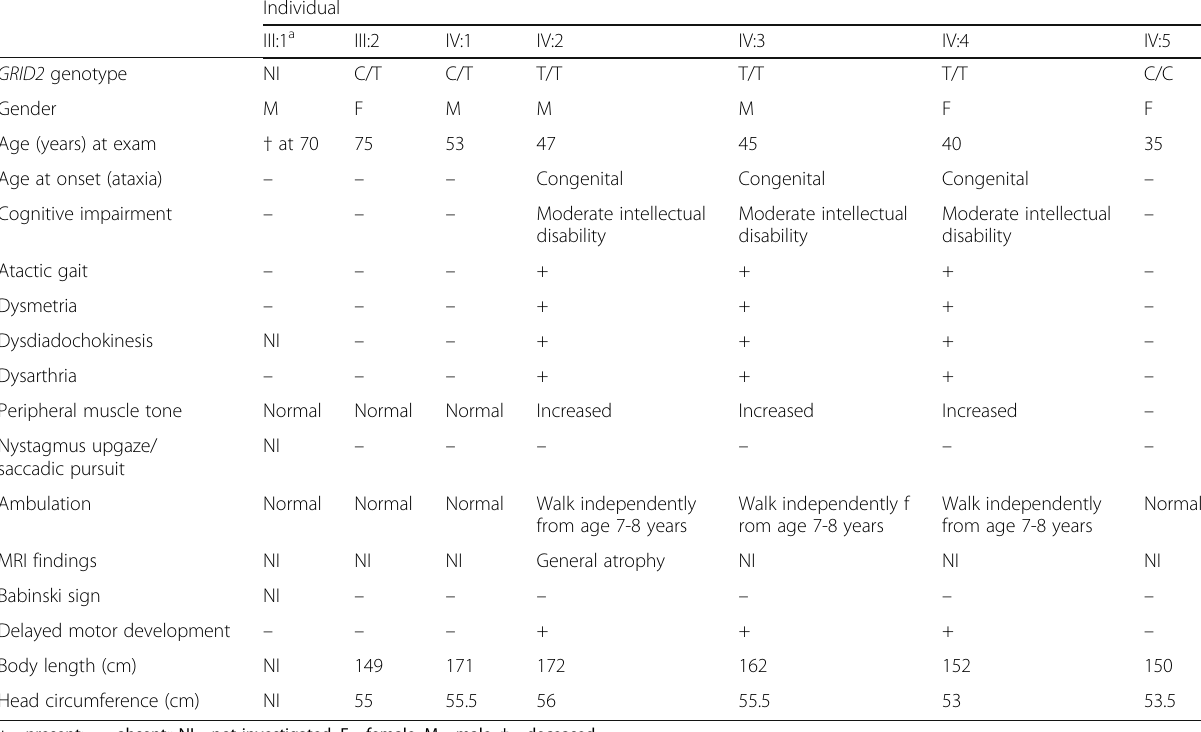
Table 1 Clinical features of family